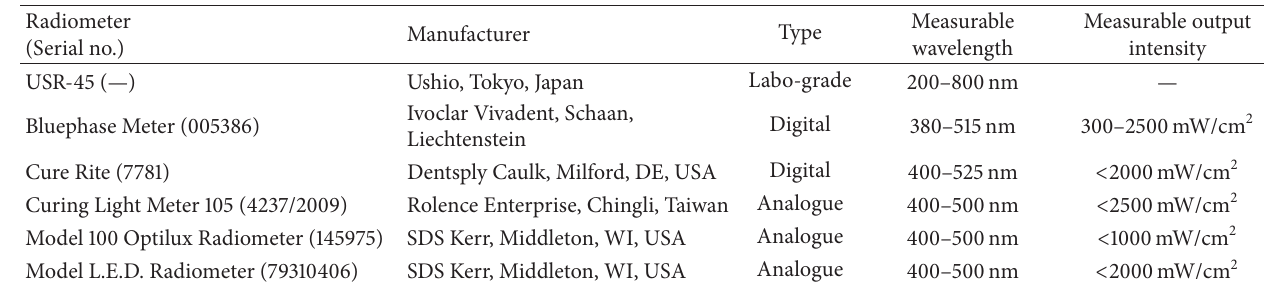
Table 2: Radiometers investigated in this